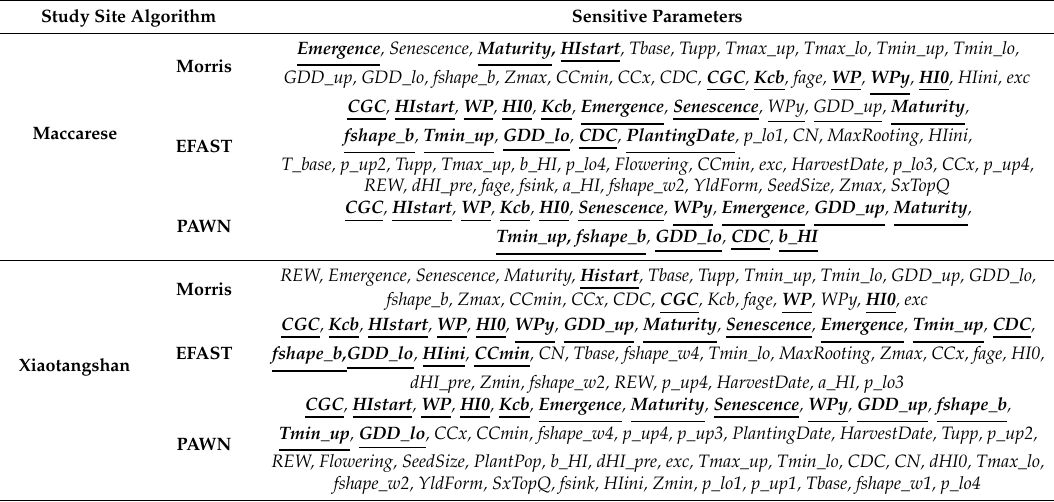
The most influential parameters are in bold and